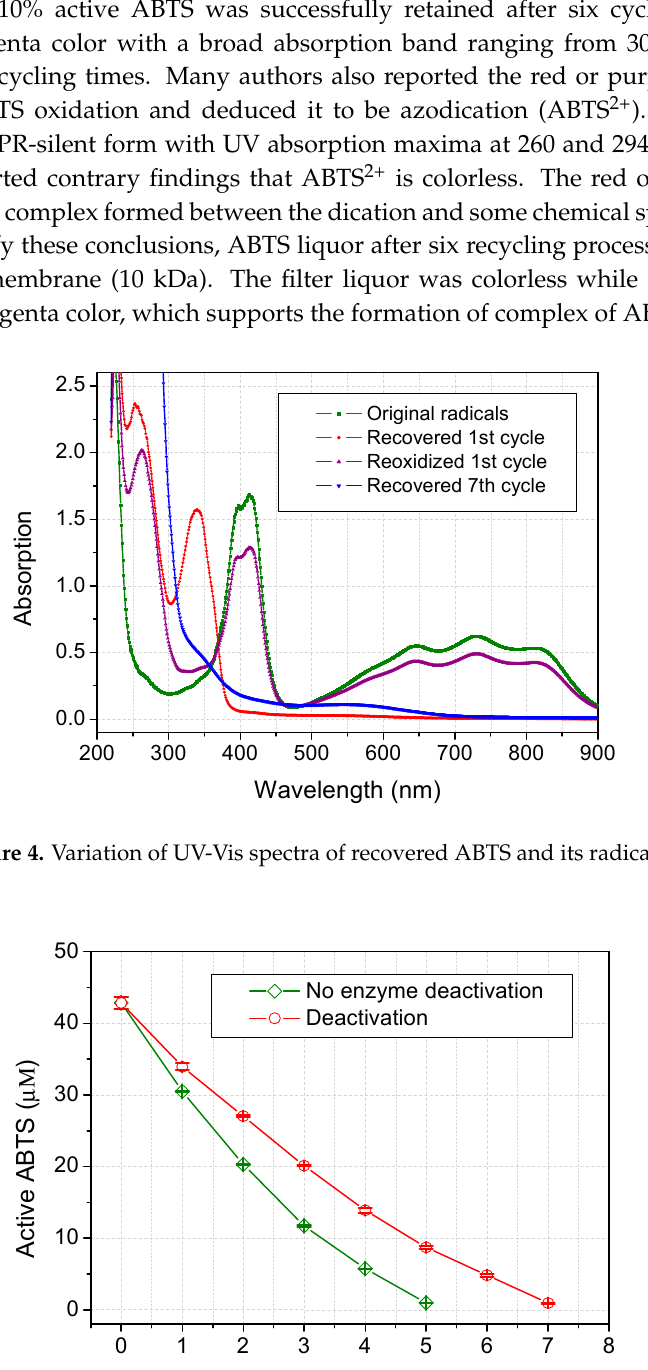
Figure 5. Attenuation of active ABTS radicals with recycling times.